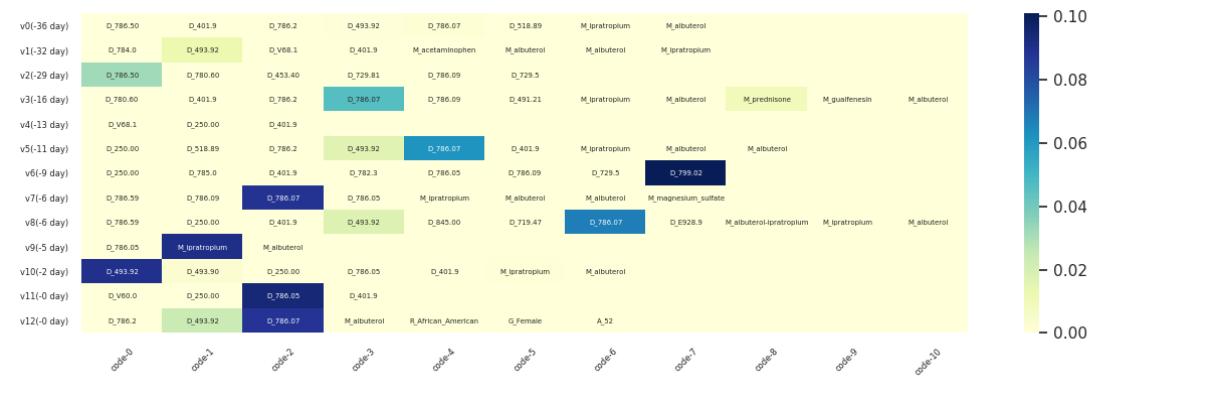
Figure 4. An example of a heatmap with highly associated clinical variables, such as hypoxemia (D_799.02), shortness of breath (D_786.05), and wheezing